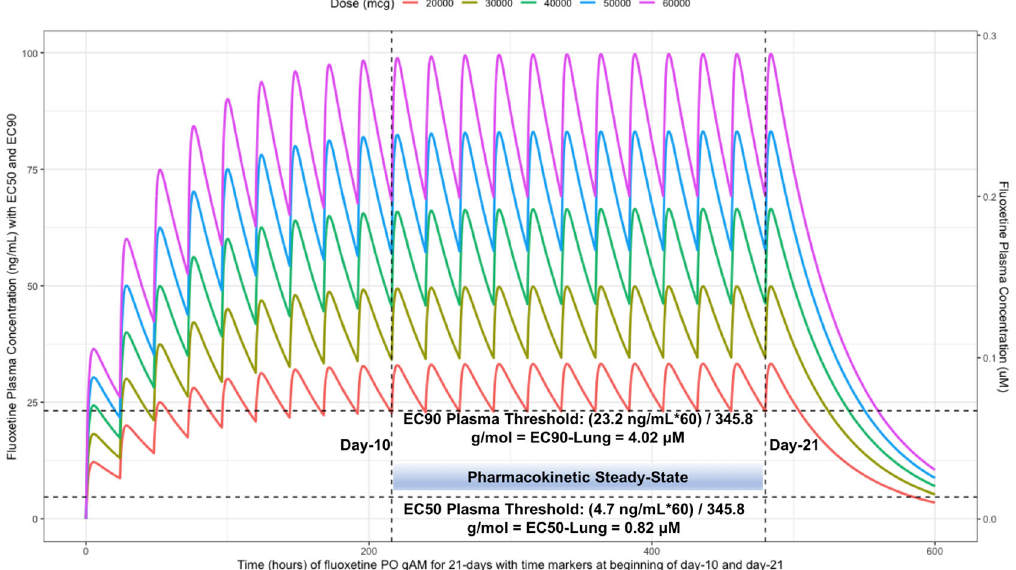
Figure 7. Fluoxetine concentration-time profile in human plasma at standard daily antidepressant doses (20 mg/day, 30 mg/day, 40mg/day, 50 mg/day, 60 mg/day) throughout 21 days. The two vertical line illustrates the morning doses on day-10 and on day-21. The highest (EC90) and lowest (EC50) horizontal lines illustrates the threshold for the plasma effective concentrations inhibiting 50% and 90% of SARS-CoV-2 titers that distributes to 60-times higher concentrations within the lungs,